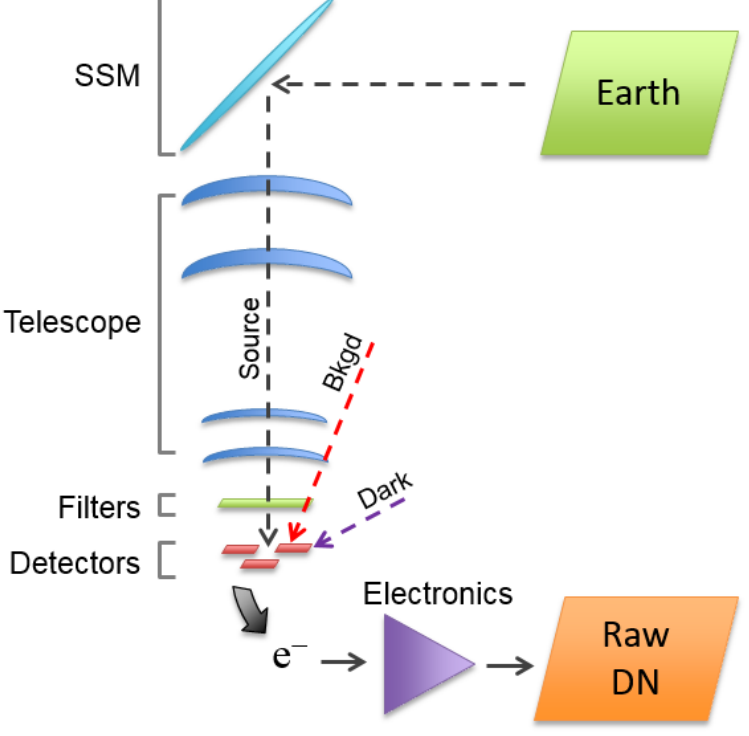
Figure 2. Diagram indicating the three major energy paths (the source, the background and the dark signal) reaching the detectors and contributing to the recorded raw